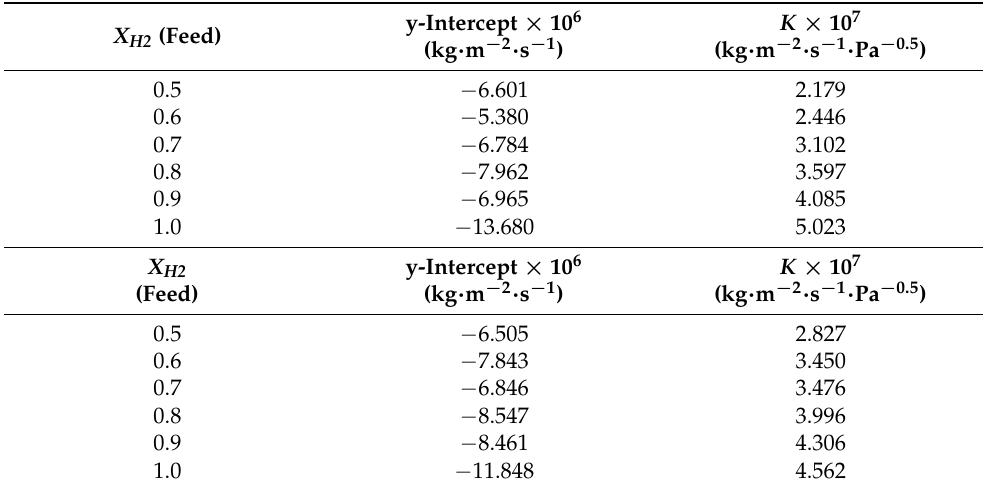
Table 2. Main permeation parameters at 375 ◦ C and different H 2 feed molar fractions ( X H2 ) obtained from experimental data: y-intercept and H 2 permeance ( K